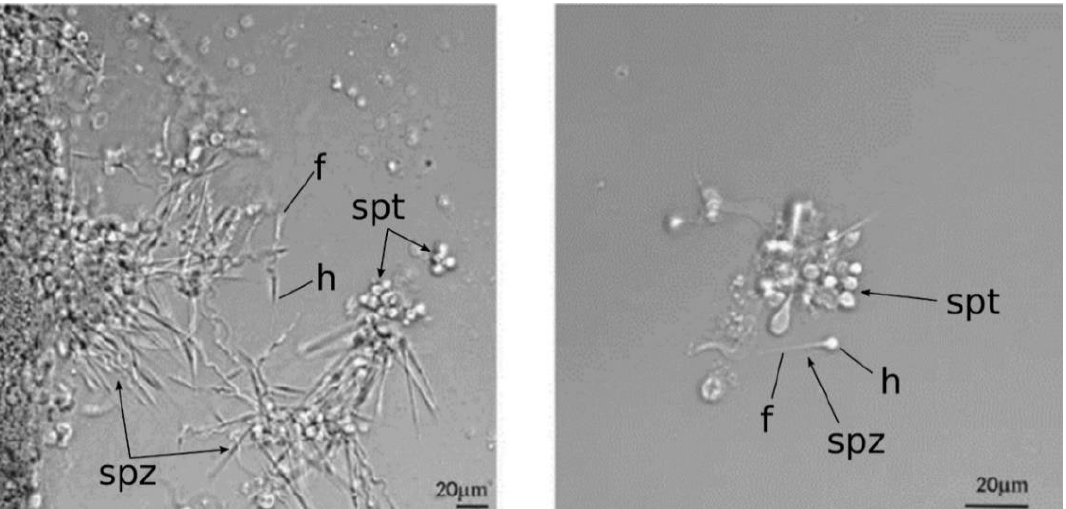
Figure 3. Sperm morphology is affected in Mlig-SKP1 (RNAi) animals. DIC images are shown. Normal sperm from the worms treated by GFP dsRNA is on the left and sperm of the Mlig-SKP1 (RNAi) worms is on the right. Instead of normal sperm maturation involving splitting of sphere-like tetramers into filamentous mature sperm cells [15], sperm of Mlig-SKP1 (RNAi) worms is still carrying a sphere-like head and the tail is not well formed. Spermatozoa (spz) and spermatids (spt) are indicated by arrows. h — head of sperm cell, f — flagellum.